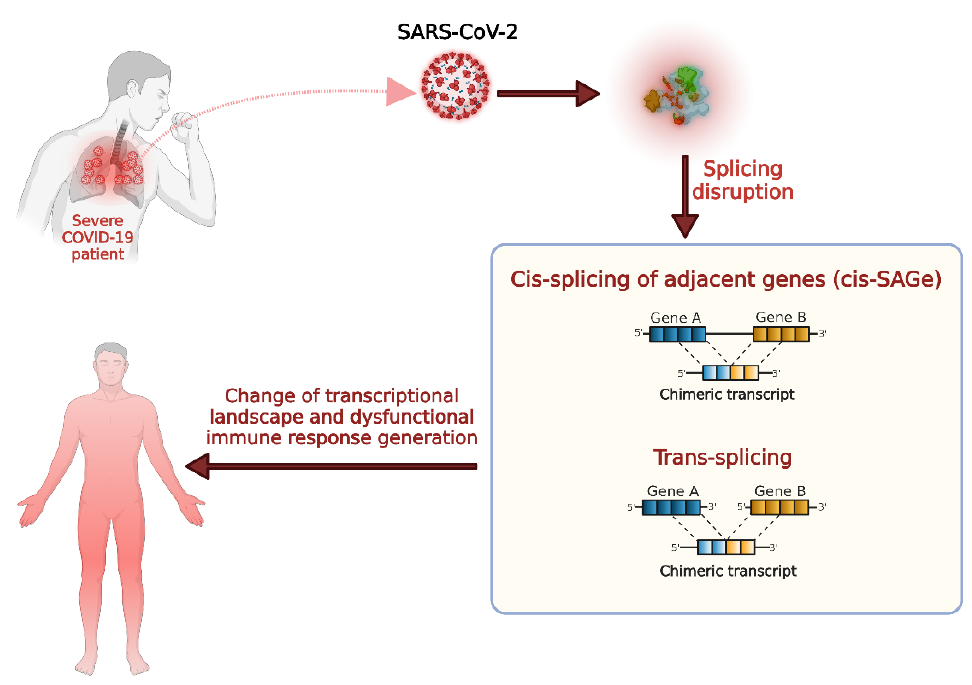
Figure 6. Schematic representation of the generation of chimeric transcripts in severe COVID-19 and their potential functional impact.